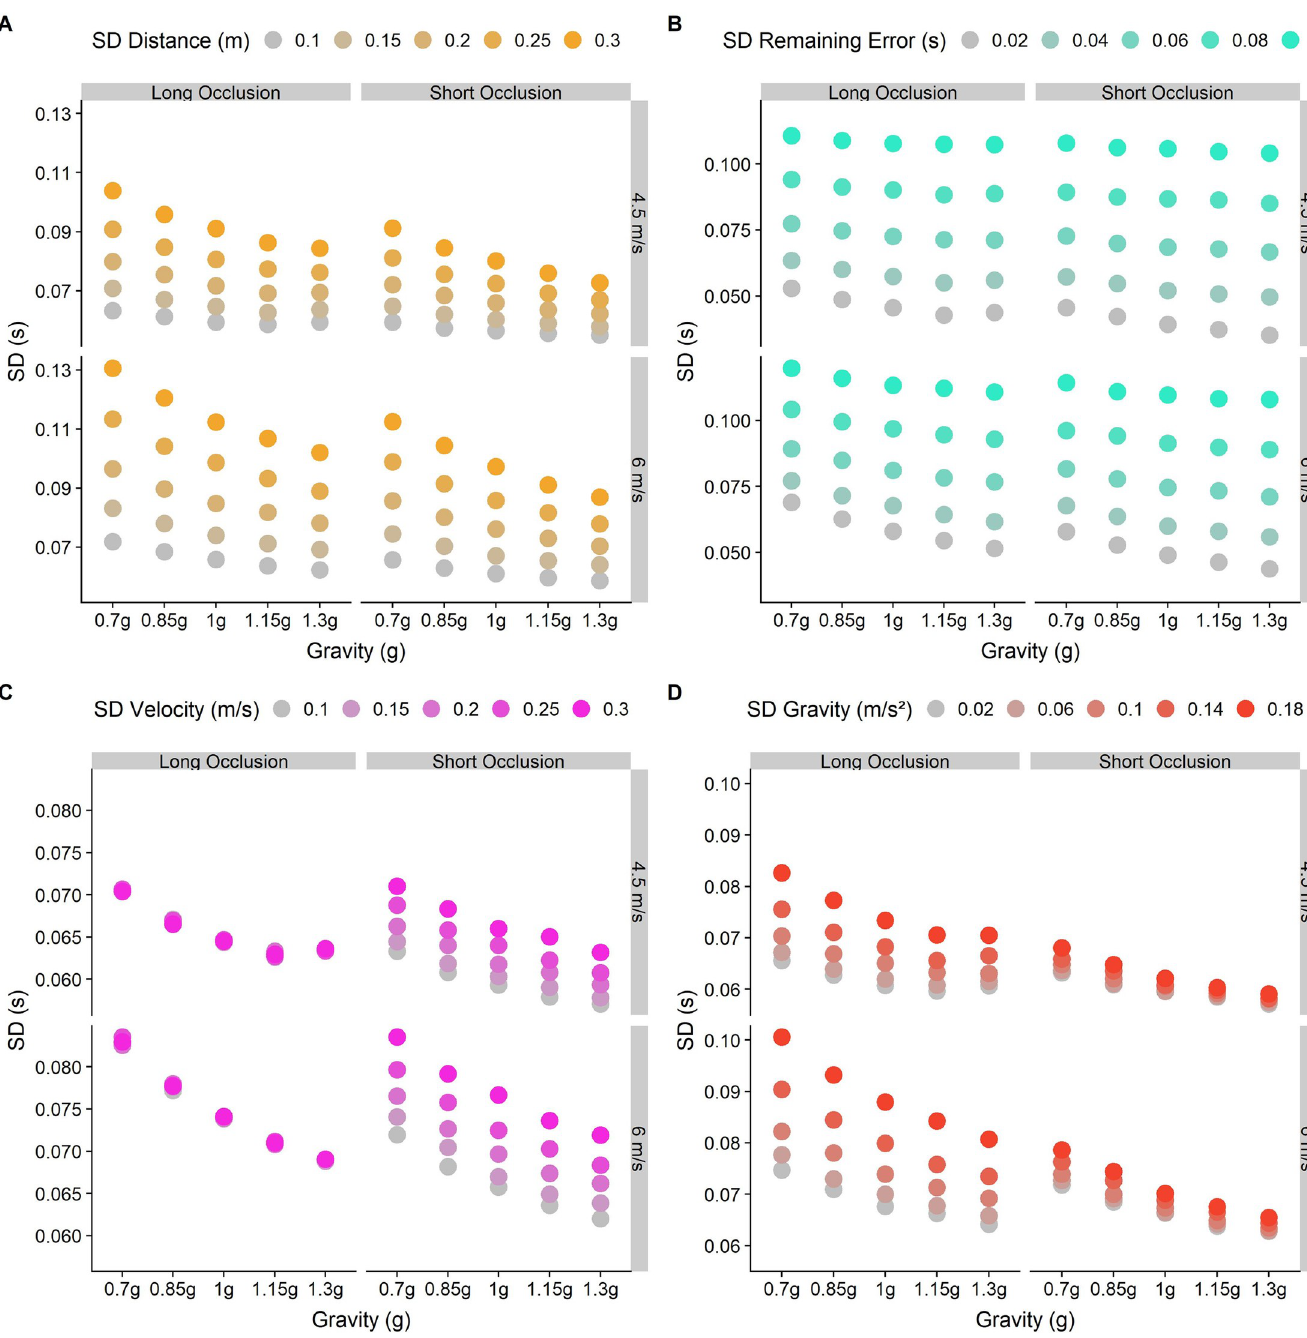
Fig 5. Predictions for different standard deviations chosen for different parameters in our model. Dots represent the standard deviation for each gravity (0.7g-1.3g), divided by Occlusion category (Long and Short) and initial vertical velocities (4.5 and 6 m/s). The color gradient indicates different values of the (standardized) standard deviation for the perceived distance, the perceived velocity, the represented gravity and the remaining error. The baseline values are 0.148 for distance and velocity, 0.1 for gravity and 0.05 for the remaining (motor) error. A. Predictions for five standardized standard deviations for the perceived distance (0.1–0.3 m). B. Predictions for five standard deviations for the remaining (motor) error (0.02–0.1 s), modelled as independent of and constant across initial velocities, gravities and occlusion conditions. C. Predictions for five different standardized standard deviations for the last perceived velocity (0.1–0.3 m/s). D. Predictions for five different standardized standard deviations for the represented gravity (0.02–0.18 m/s 2